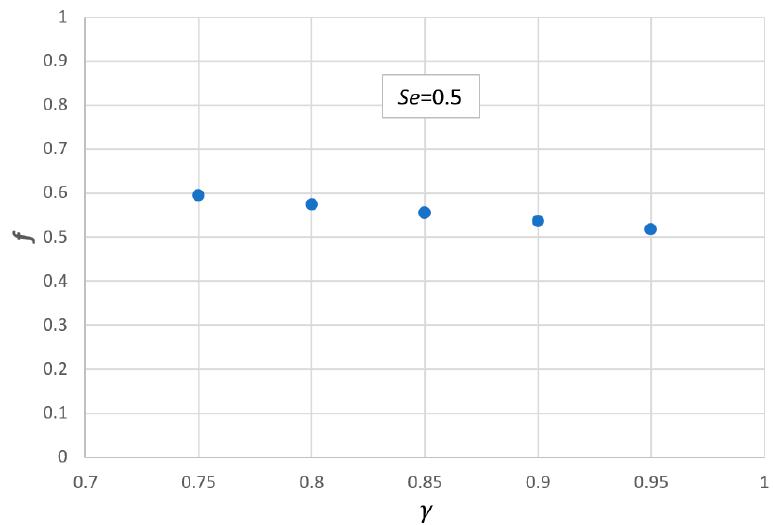
Figure 4. The fraction of fingering flow zone f for S e = 0.5 and γ between 0.75 and 0.95.